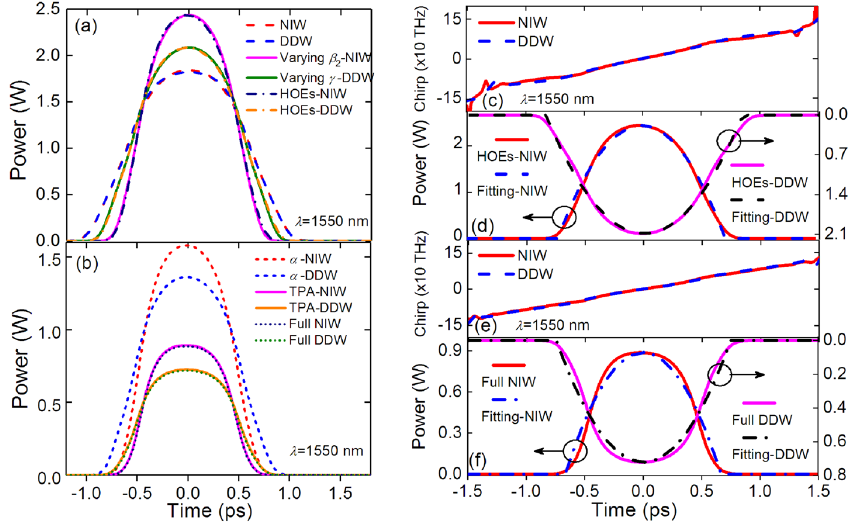
Figure 7. Output pulses with pump wavelength 1550 nm. ( a ) Output pulse waveforms with ideal NIW (red dashed curve), ideal DDW(blue dashed curve), varying β 2 -NIW (magenta solid curve), varying γ -DDW (orange solid curve), HOEs-NIW (navy dash-dotted curve), and HOEs-DDW (olive dash-dotted curve), ( b ) Output pulse waveforms with lossy terms in α -NIW (red short dashed curve), α -DDW (blue short dashed curve), TPA-NIW (magenta solid curve), TPA-DDW (orange solid curve), Full NIW (navy dotted curve) and Full DDW (olive dotted curve). ( c ) Chirp profiles of pulses from HOEs-NIW (red solid curves) and HOEs- DDW (blue dashed curve). ( d ) Output pulses of HOEs-NIW (red solid curve), parabolic fit for NIW (blue dashed curve), HOEs-DDW (magenta solid curve), and parabolic fit for DDW (black dashed curve). ( e ) Chirp profiles of pulses from Full NIW (red solid curve) and Full DDW (blue dashed curve). ( f ) Output pulses of Full NIW (red solid curve), parabolic fit for NIW (blue dash-dotted curve), Full DDW (magenta solid curve), and parabolic fit for DDW (black dash-dotted